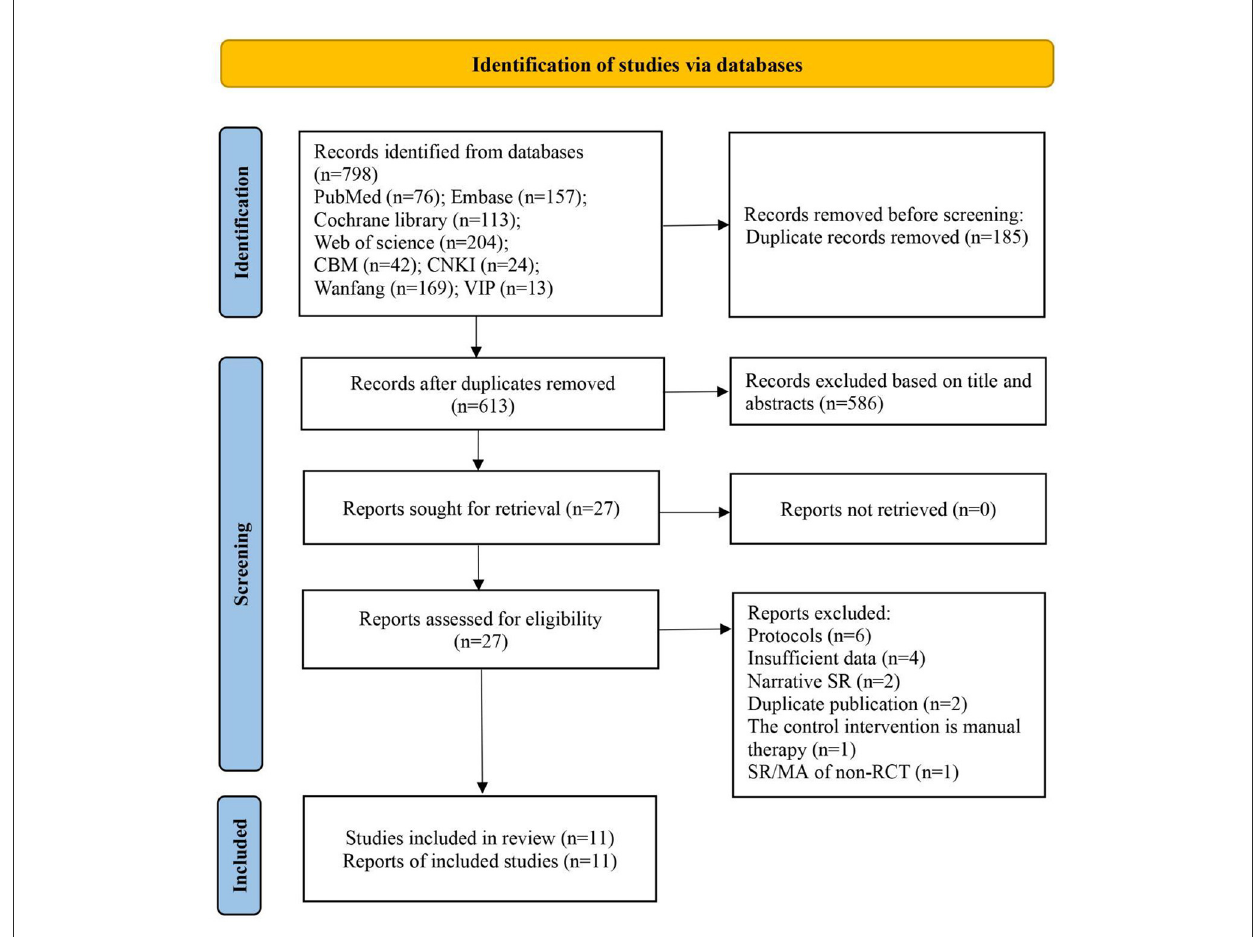
FIGURE2 The PRISMA flow diagram of study